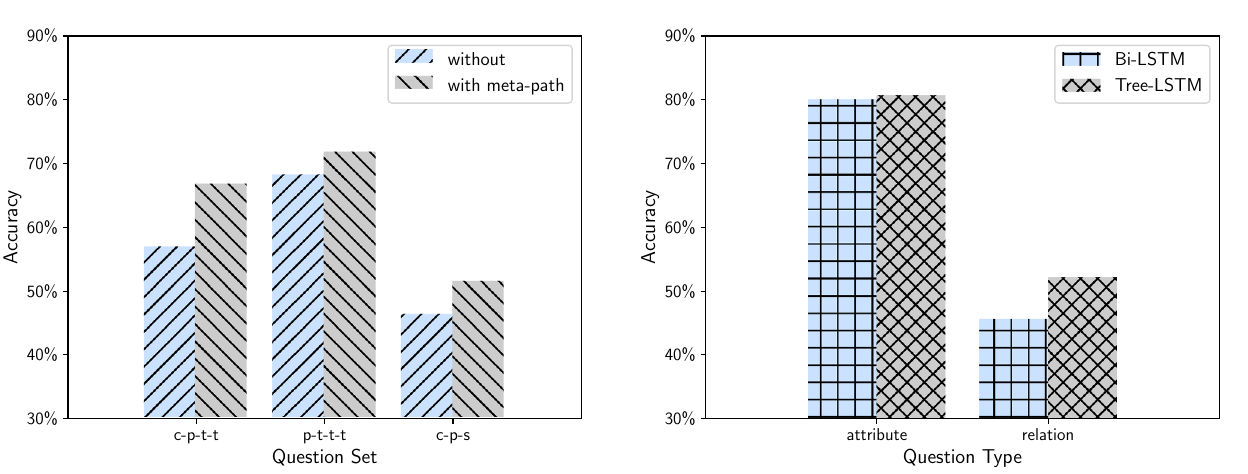
Fig. 8 QA accuracy under different meta-path context Fig. 9 QA accuracy with/without tree model in